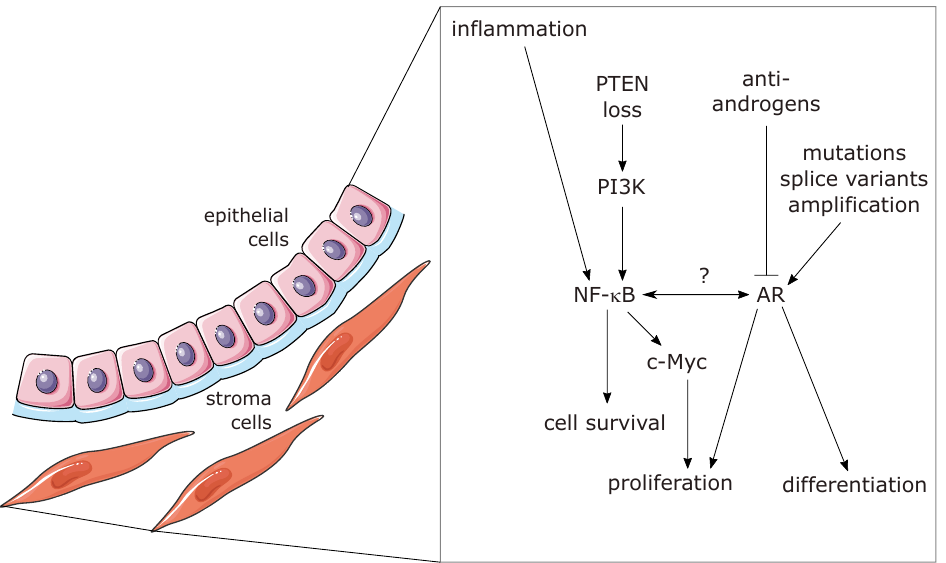
Figure 1. Schematic illustration of links between AR, NF- κ B, other relevant signaling molecules, and biological processes in prostate